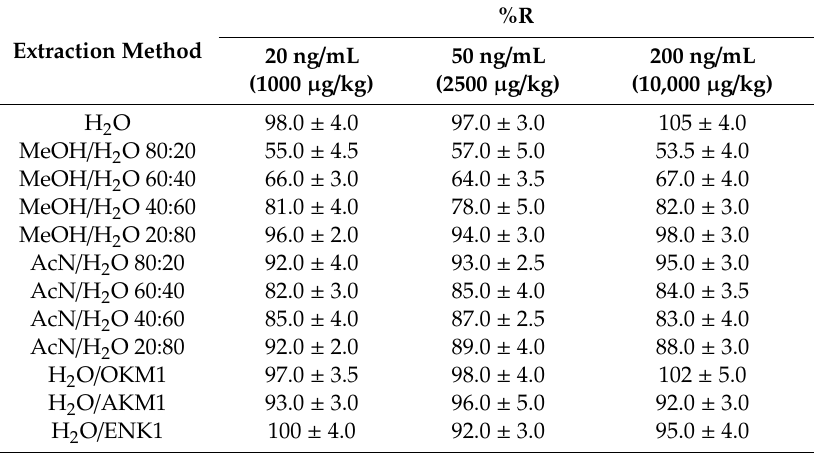
Table 1. Mean percent recovery (%R) ± 1 standard deviation values determined for spiked maize samples after application of di ff erent extraction methods. Each sample was analyzed in